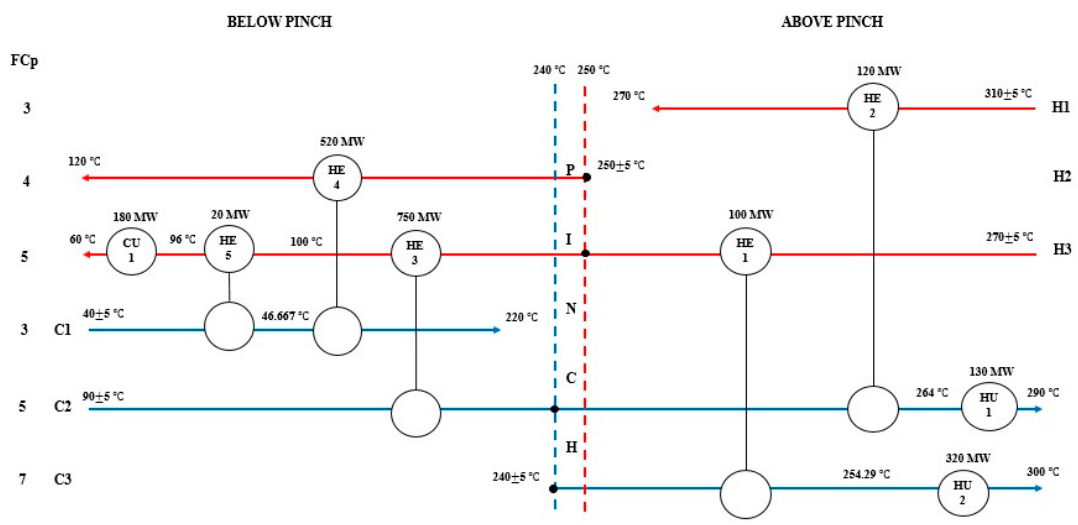
Figure 2. Maximum energy recovery (MER) heat exchanger network (HEN) design for the nominal case.